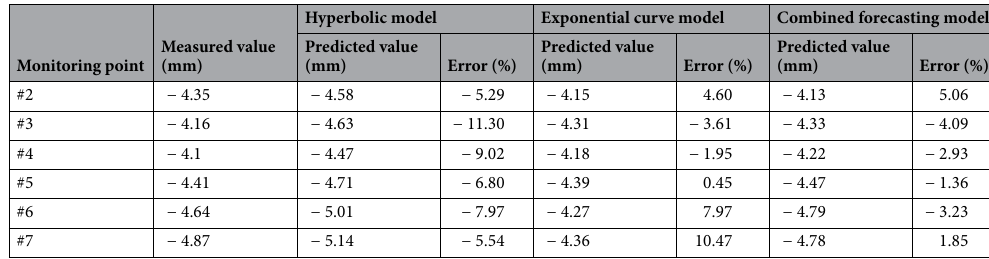
Table 9. Analysis of cumulative differential settlement prediction model of monitoring